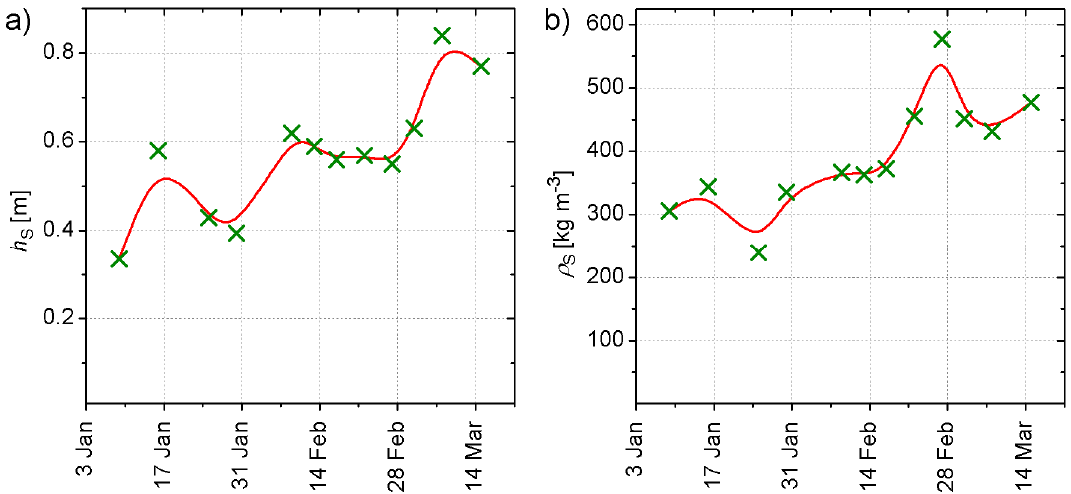
Figure 2. ( a ) Measured snowpack height h S ; and ( b ) average bottom-layer snow density ρ S over time. The snow cover quickly melted down in the second half of March 2017 and almost disappeared within approximately the last 10 day of the measurement campaign. Remote Sens. 2017 , 9 , 1185 5 of 28